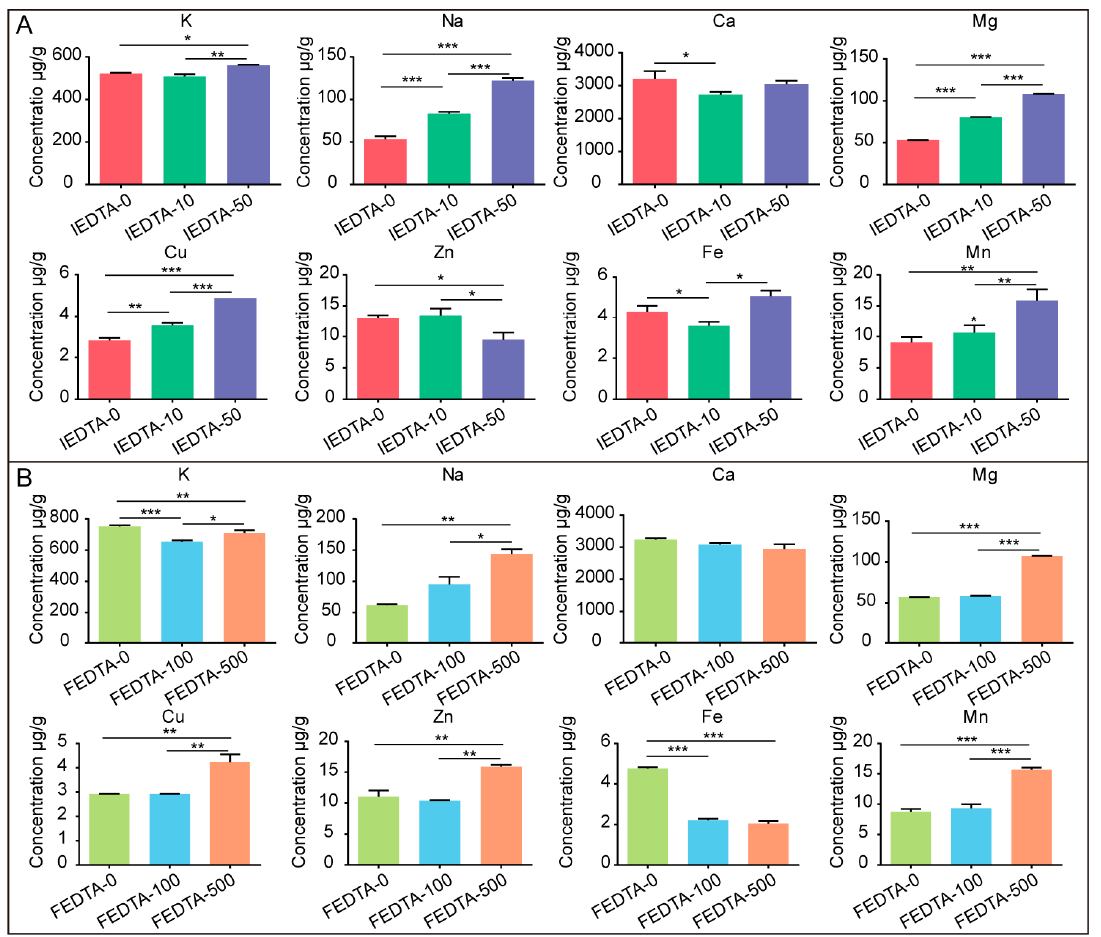
Figure 3. The content of metal elements in silk fiber after treatment. ( A ) The EDTA silk fiber after injection; ( B ) The EDTA silk fiber after feeding. Error bars, SD, * p < 0.05, ** p < 0.01, *** p < 0.001 (One-way ANOVA).